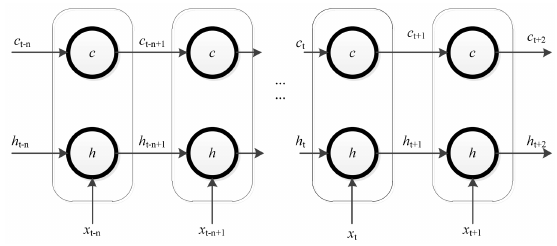
Figure 2. The unrolled LSTM sequential